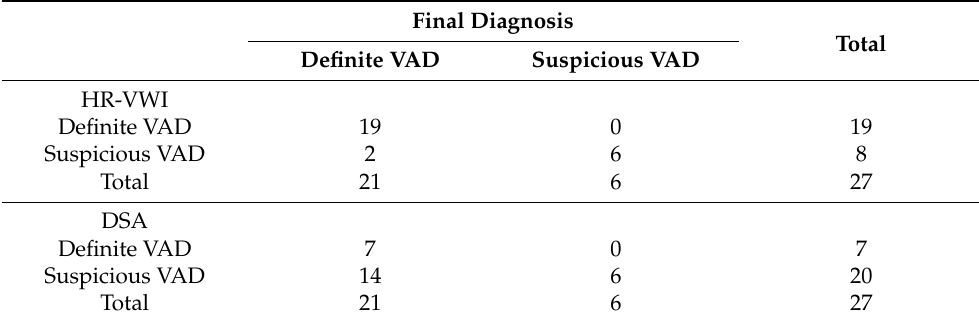
Table 3. Diagnostic performance of HR-VWI and DSA compared to final diagnosis.